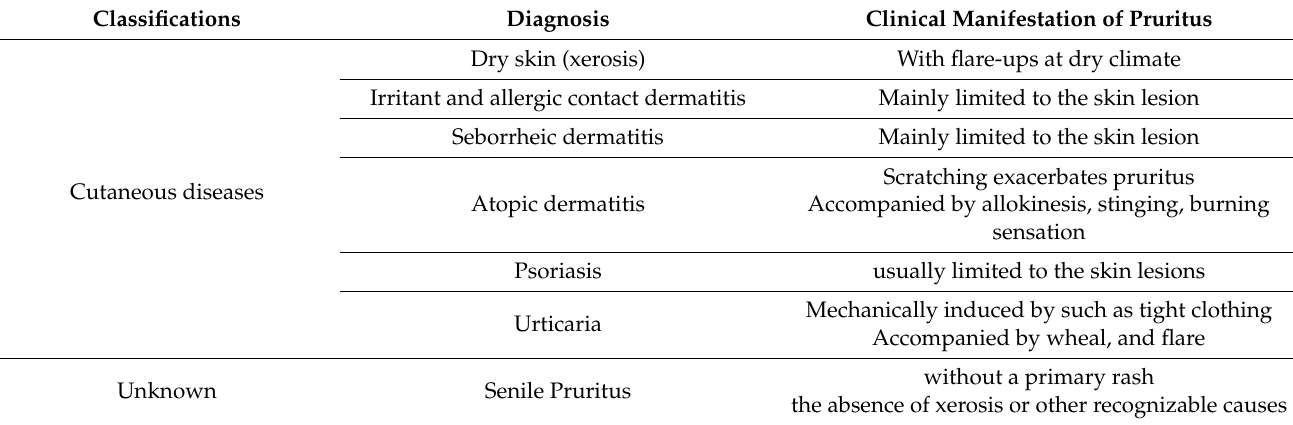
Table 1. Causes and characteristics of pruritus in various diseases in elderly